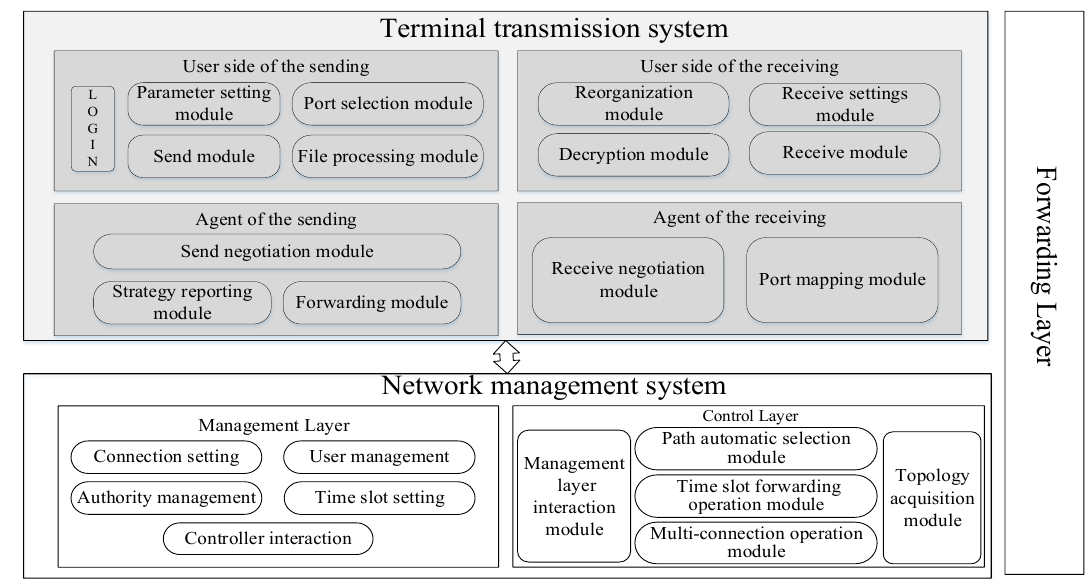
Figure 2. Architecture of the Secure Channel Service